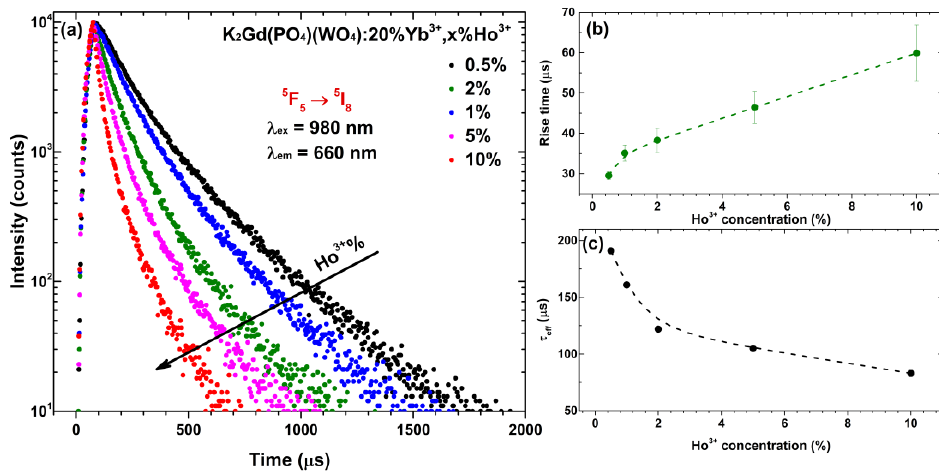
Figure 6. ( a ) Up-conversion PL decay curves ( λ ex = 980 nm, λ em = 660 nm) of K 2 Gd(PO 4 )(WO 4 ):20%Yb 3+ ,Ho 3+ as a function of Ho 3+ concentration, ( b ) PL rise time and ( c ) effective decay lifetime ( τ eff ) values of the same samples as a function of Ho 3+ concentration. Table 1. UC PL lifetime values of inorganic host matrixes doped with Ho 3+ . Upconverting Material UC PL Lifetime ( μ s) Ref. BaGdF 5 :20%Yb 3+ ,1%Ho 3+ 131 [28] Sr 3 Y(PO 4 ) 3 :10%Yb 3+ ,2%Ho 3+ 261 [48] cubic BaTiO 3 :3%Yb 3+ ,0.2%Ho 3+ 155 [11] tetragonal BaTiO 3 :3%Yb 3+ ,0.2%Ho 3+ 125 [11] La 9.31 (Si 1.04 O 4 ) 6 O 2 :20%Yb 3+ ,1%Ho 3+ [49] TeO 2 – WO 3 glass 191 This work 83 This work